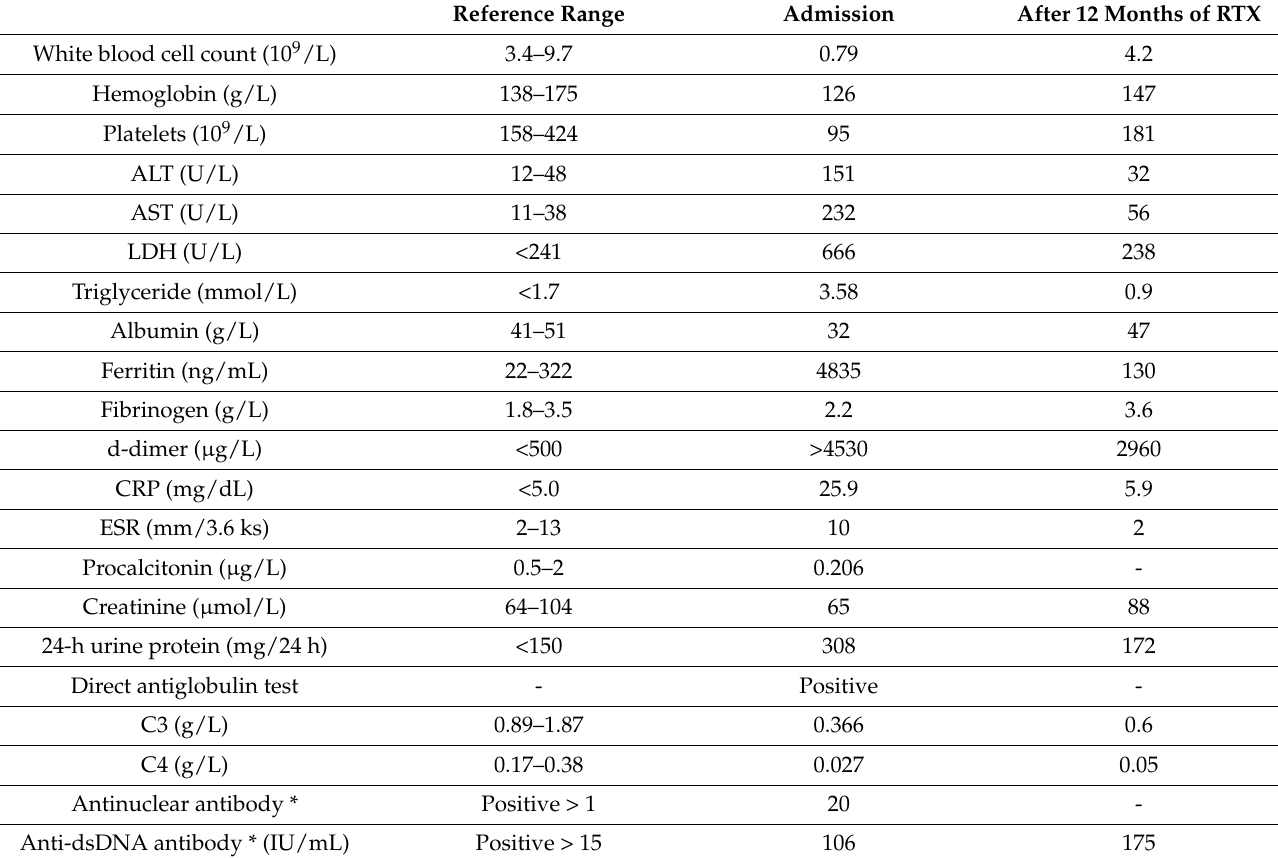
Table 1. Laboratory data upon admission and 12 months after initiation of rituximab (RTX)